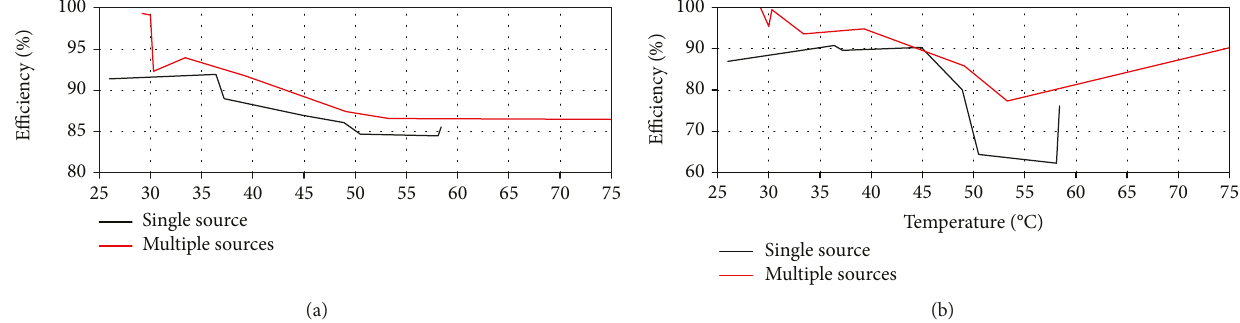
Figure 16: E ffi ciency of the system: (a) simulation and (b) experiment.